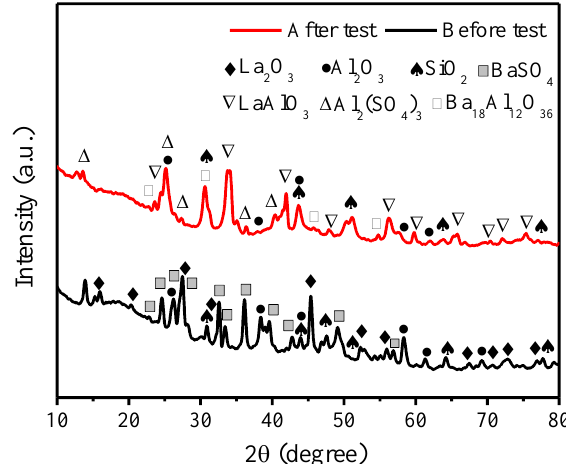
Figure 10. XRD patterns of C 0 L 15 before and after tribology testing.